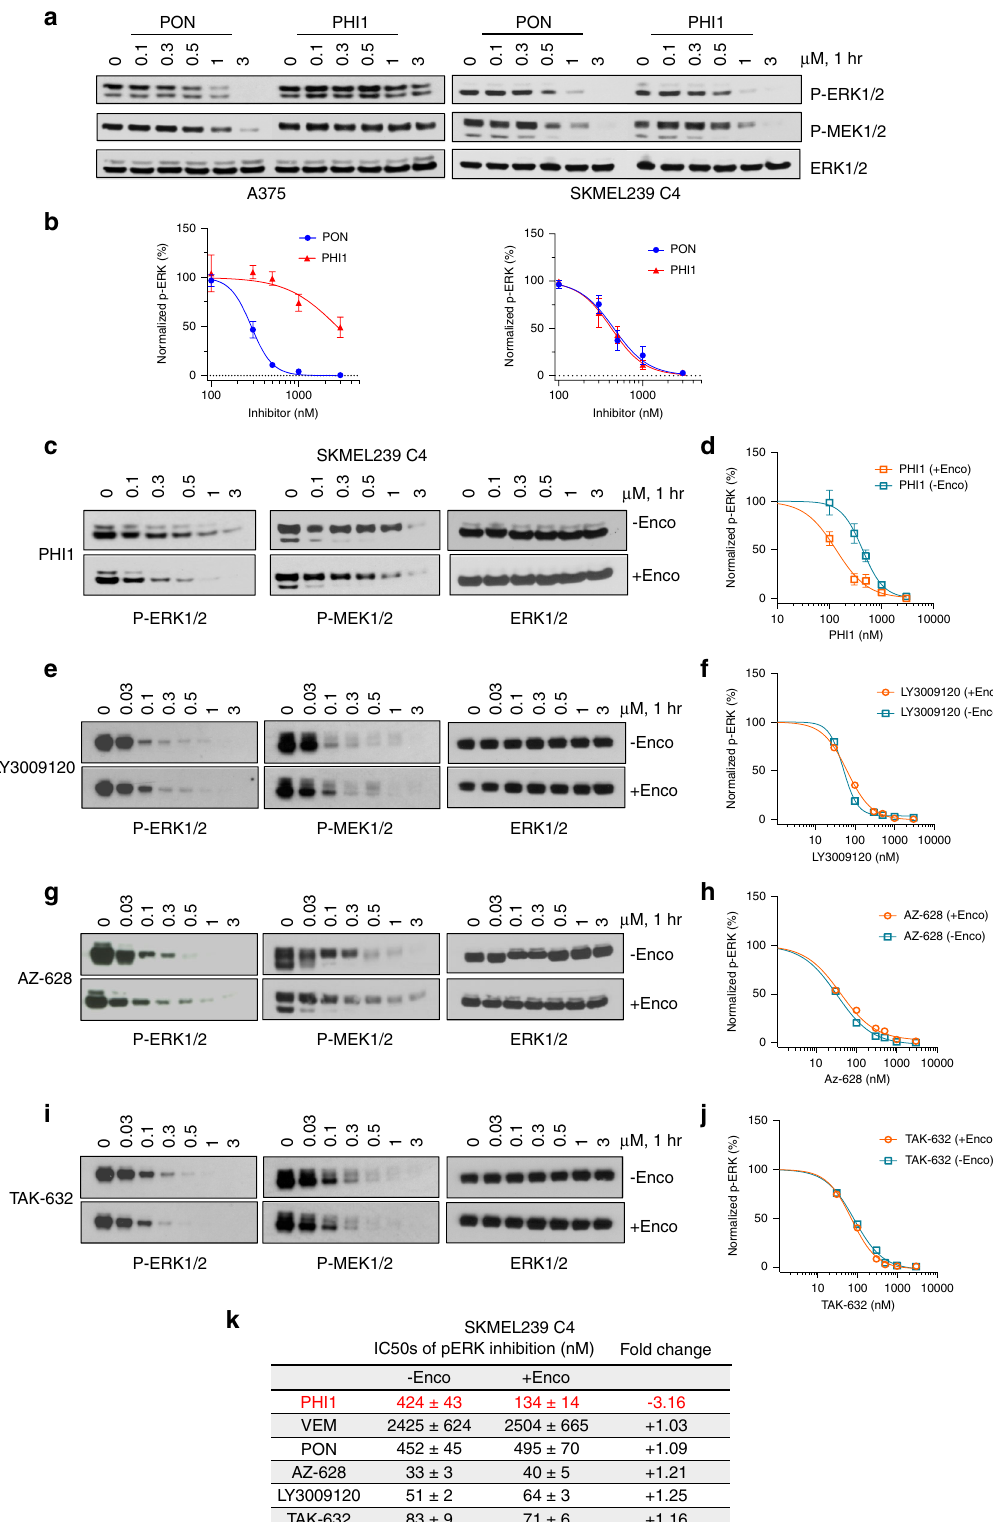
effective for targeting BRAF and ERK signaling inhibition 48 . Furthermore, potential dual targeting of BRAF and RTK inhi- bition by Ponatinib in a speci fi c oncogenic context (e.g., BRAF V600E and FGFR aberration) or in the context of adaptive resistance mechanisms through RTK signaling may be parti-